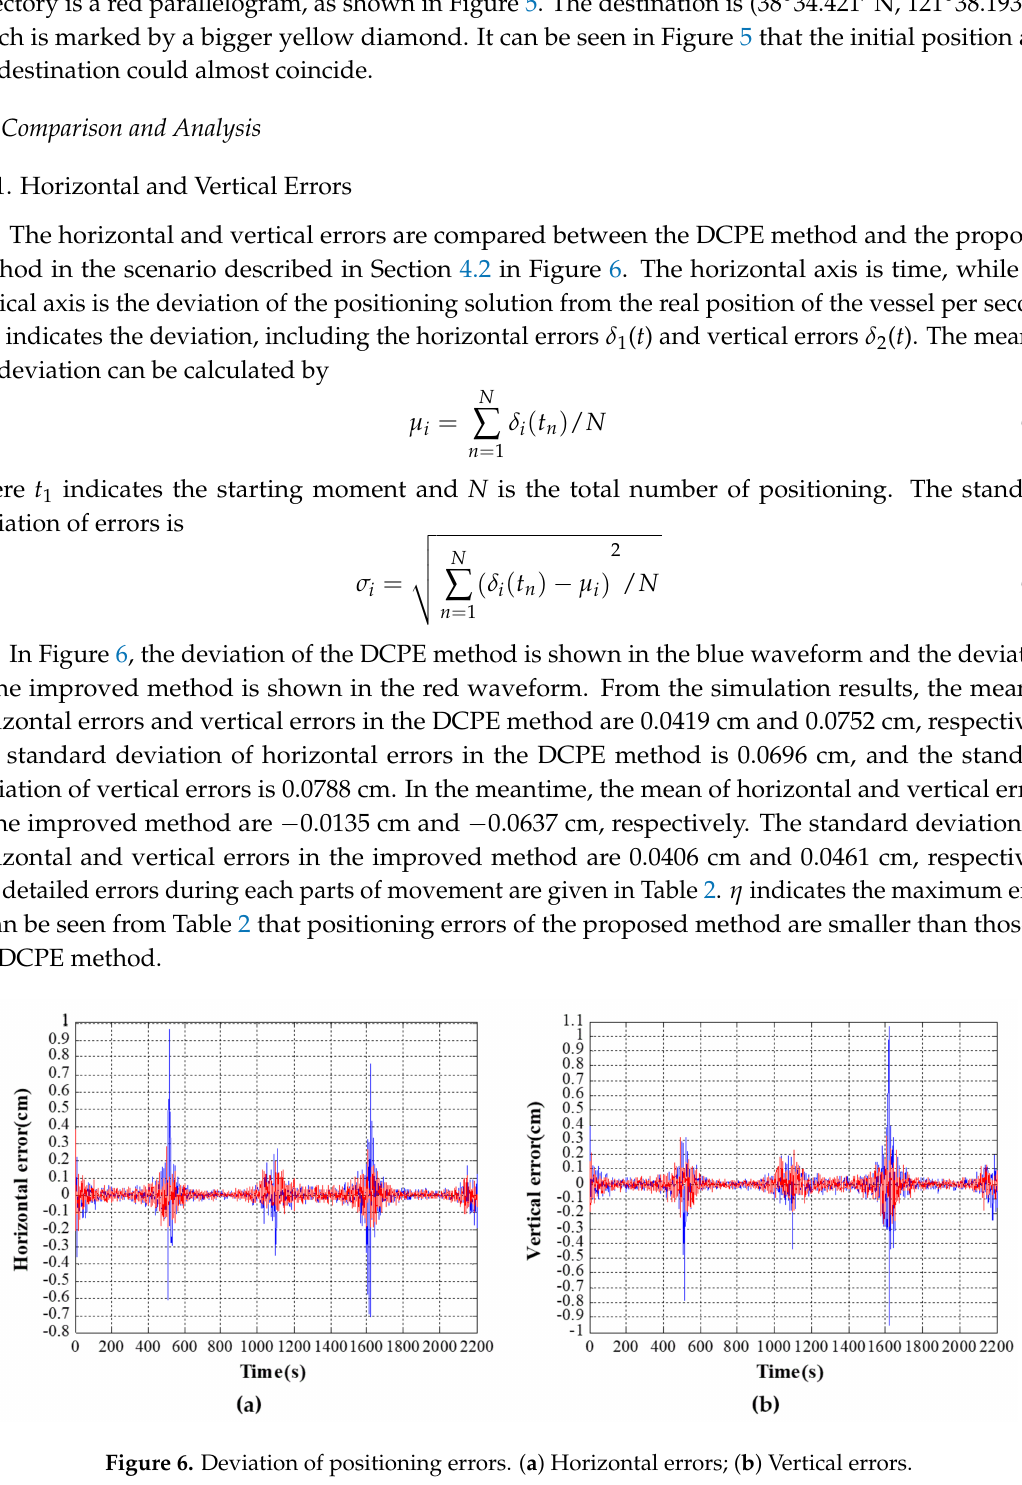
Figure 6. Deviation of positioning errors. ( a ) Horizontal errors; ( b ) Vertical